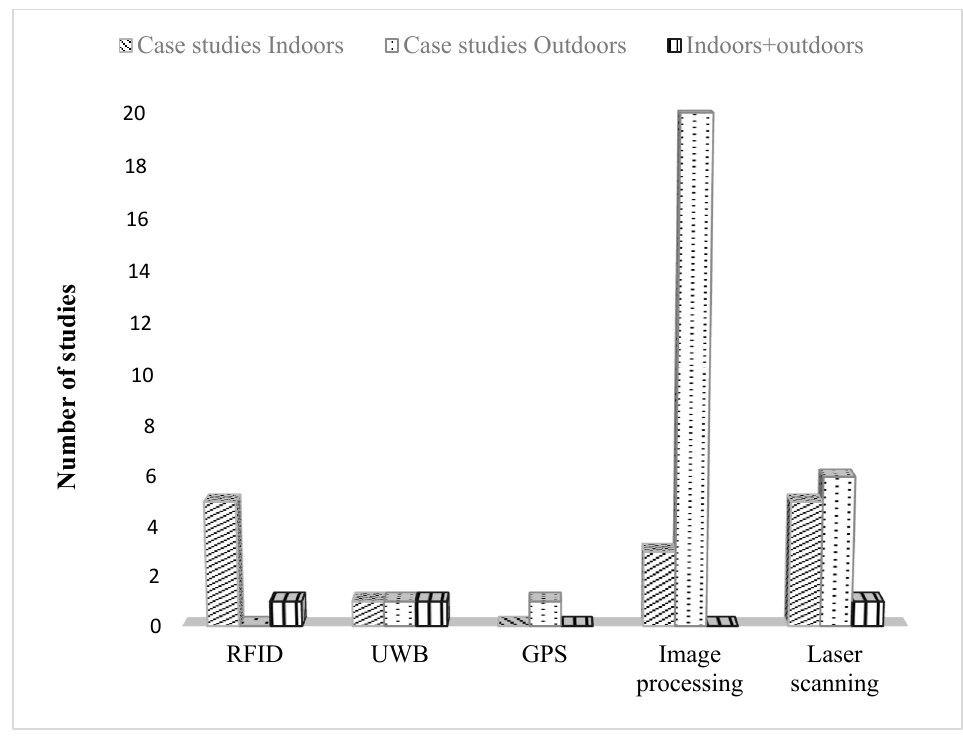
Figure 5. Scanning environment of 3D sensing technologies studies.